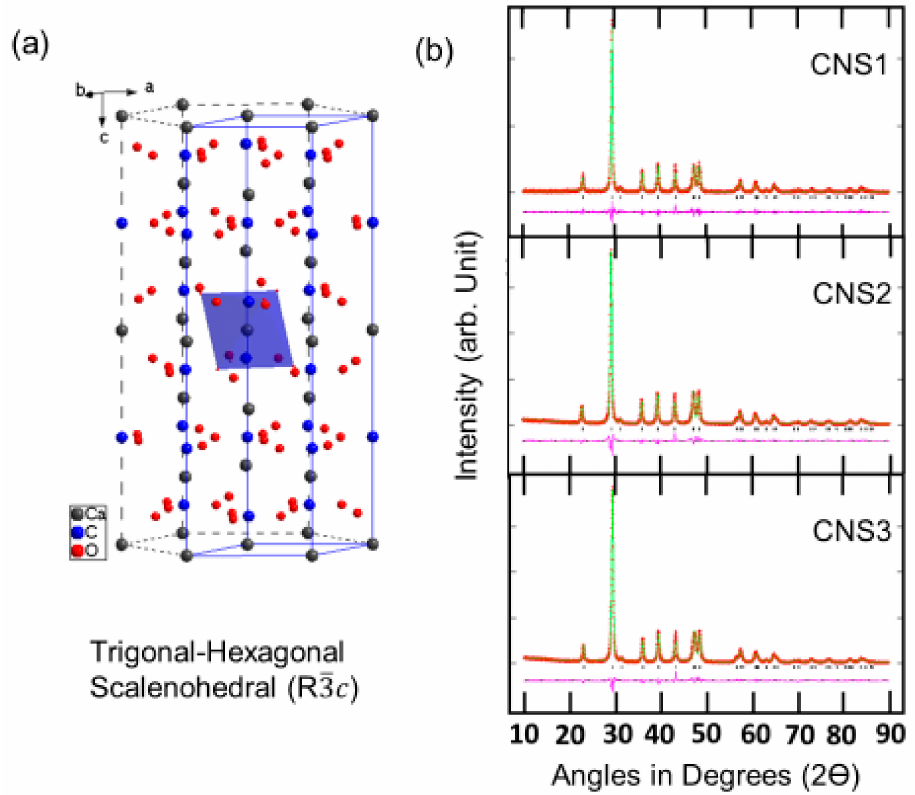
Figure 2. ( a ) Unit cell corresponding to R3c space group; ( b ) Rietveld refinement of X-ray diffraction patterns of CNS1, CNS2, and CNS3